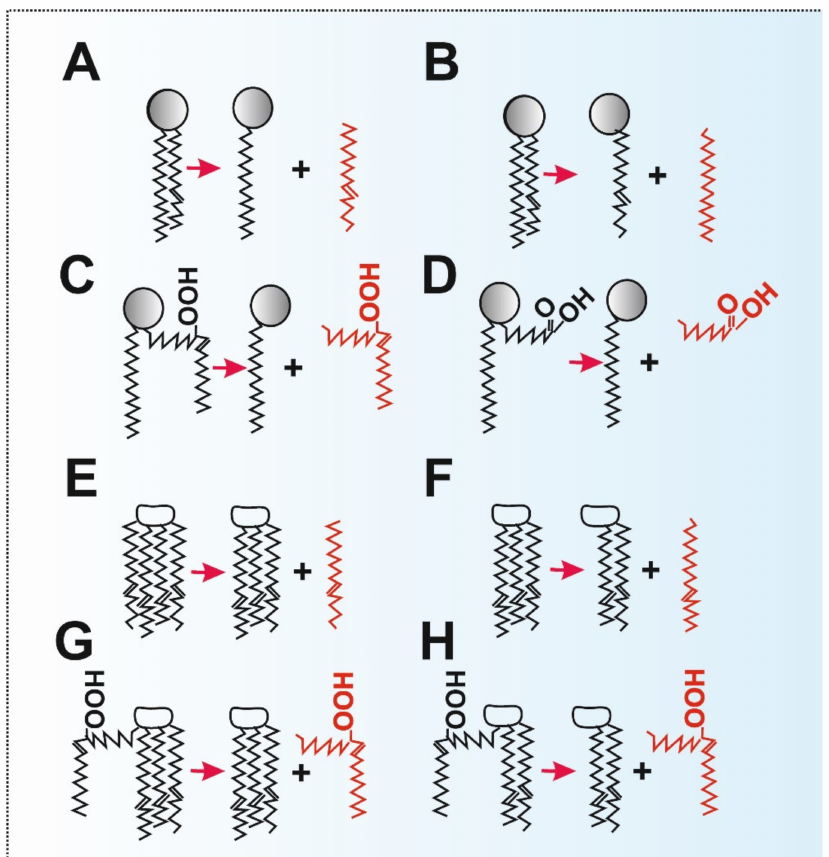
Figure 3. Cleavage modes of iPLA2 γ : ( A ) cleavage of unsaturated FA from the sn-2 position (PUFA); ( B ) cleavage of saturated FA from the sn-1 position; ( C ) cleavage of hydroperoxy FA (PUFA after lipid peroxidation) from the sn-2 position; ( D ) cleavage of the shortened alkyl chain (resulting from lipid peroxidation of PUFA and subsequent degradation of the hydroperoxy-alkyl chain); ( E ) cleavage of unsaturated FA (PUFA) from the sn-1 position of cardiolipin; ( F ) cleavage of unsaturated FA (PUFA) from the sn-2 position of monolysocardiolipin; ( G ) cleavage of hydroperoxy FA (PUFA after lipid peroxidation) from the sn-1 position of cardiolipin; ( H ) cleavage of hydroperoxy FA (PUFA after lipid peroxidation) from the sn-2 position of